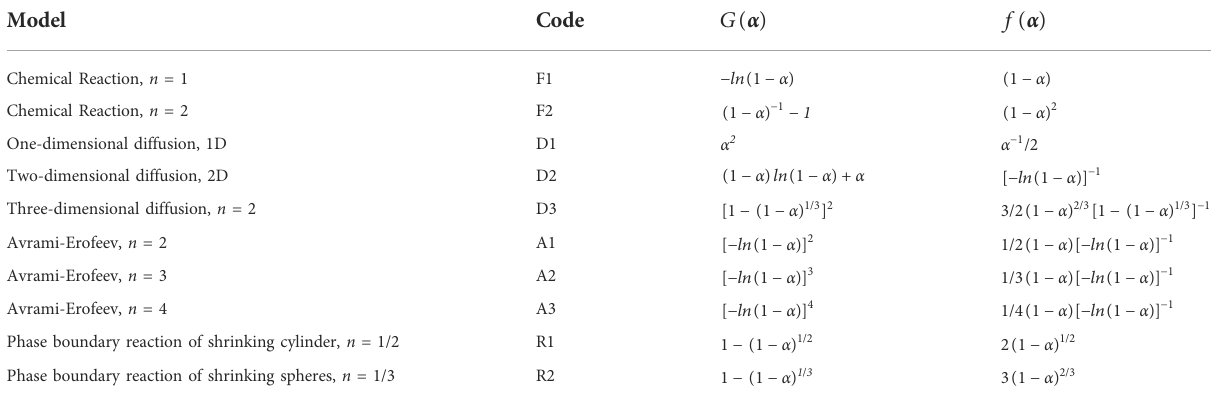
TABLE 1 Reaction mechanisms, model names with their f ( α ) and G ( α )